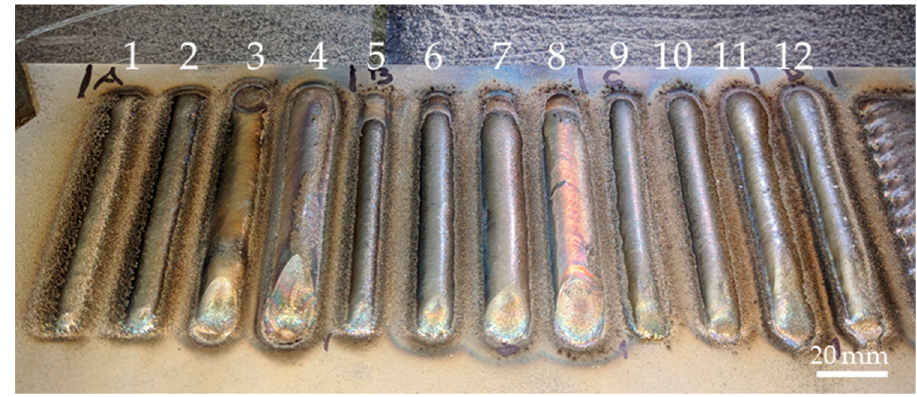
Figure 4. Processing parameters test.